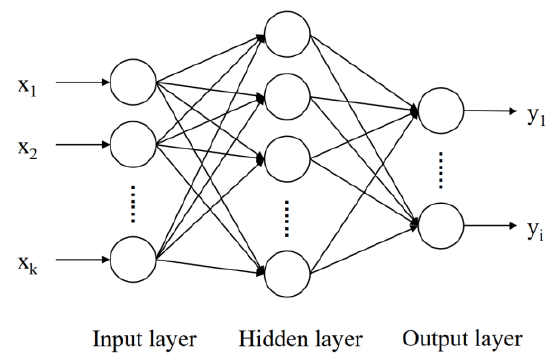
Figure 4. Topology of BP neural network.